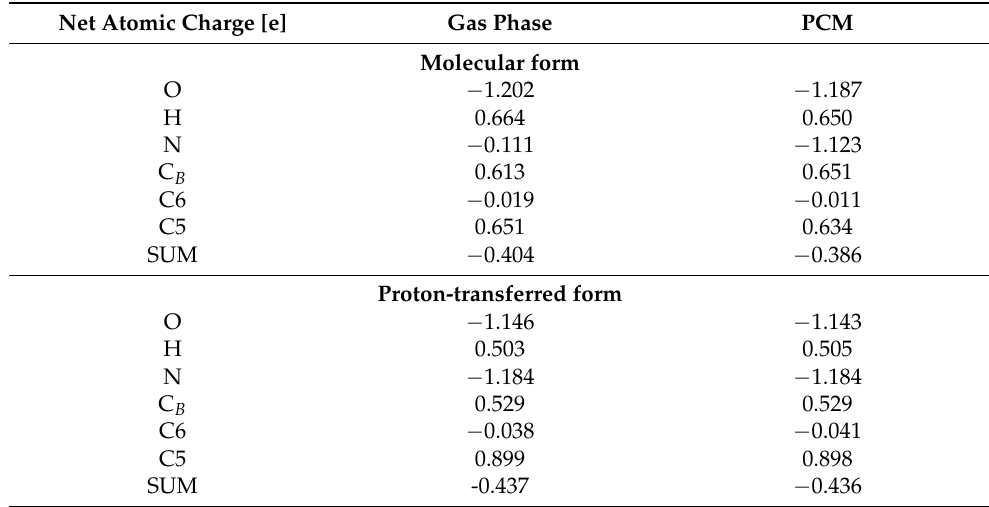
Table 2. QTAIM net atomic charges for atoms forming quasi-ring in the para isomer monosubstituted with the –NO 2 group in the proximal position